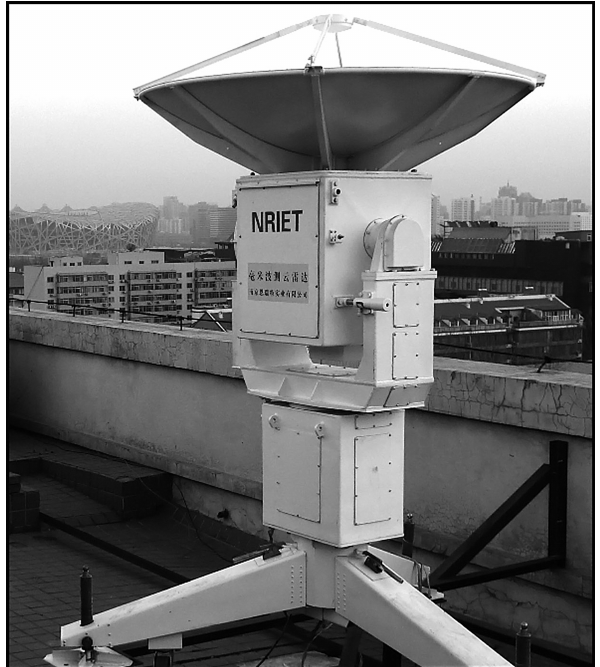
Figure 1. The Ka-band polarization Doppler radar at the Institute of Atmospheric Physics, Chinese Academy of Sciences, Beijing, China (39.967 ◦ N, 116.367 ◦ E).